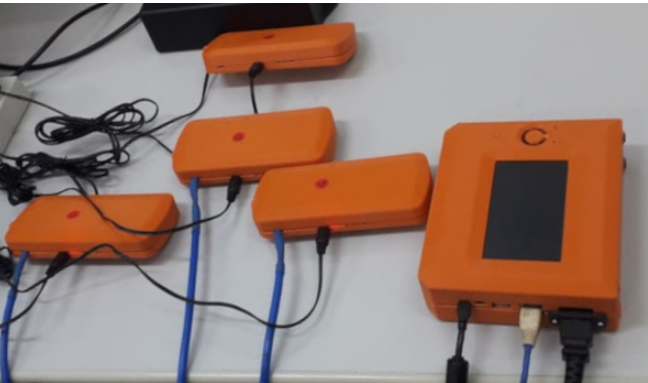
Figure 7. A photo of four router/leaf nodes and a border node being tested.